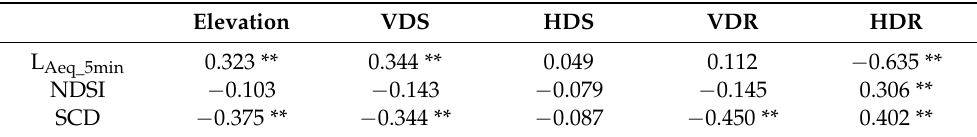
Table 4. Spearman’s rho correlation coefficients for the relationship between spatial indicators and soundscape evaluation parameters.